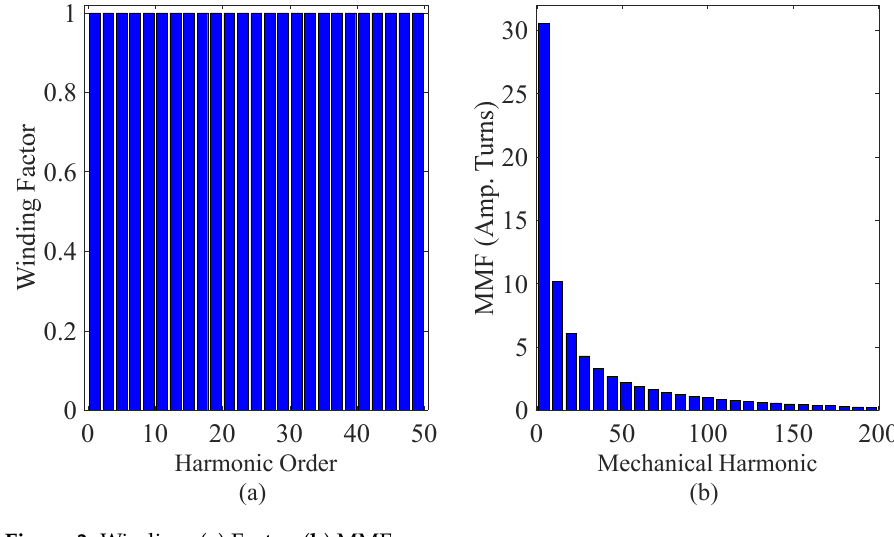
Figure 3. Winding: ( a ) Factor, ( b )